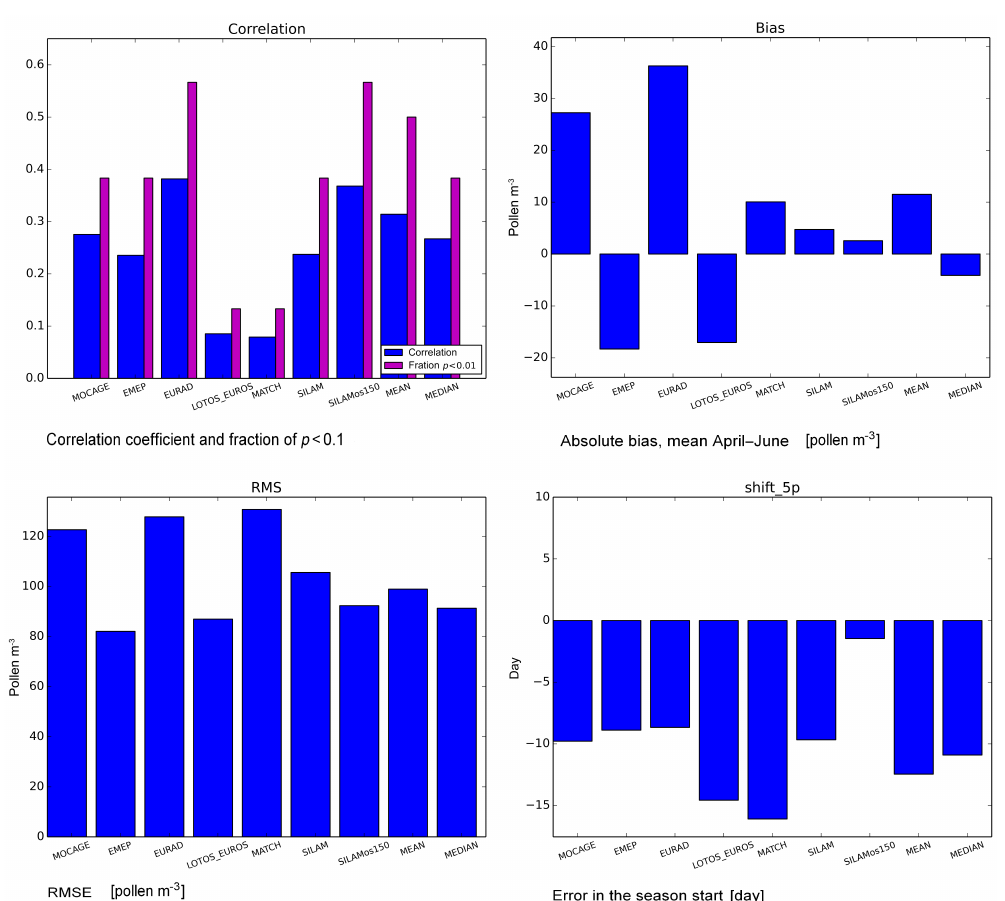
Figure 8. Scores of the individual models, mean over all stations. The same parameters as in Fig. 7. The sensitivity run SILAMos150 is explained in the discussion section.